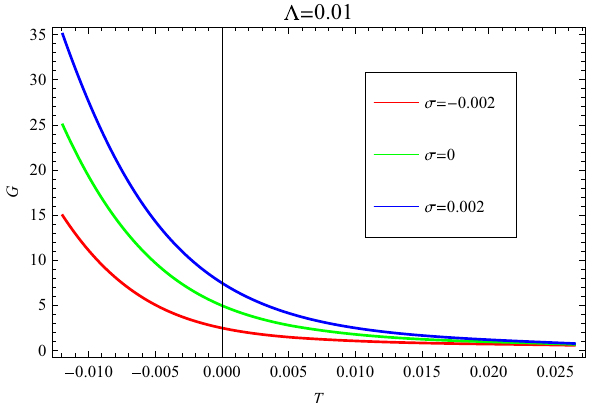
Fig. 4 Plot of effective Gibbs free energy versus effective